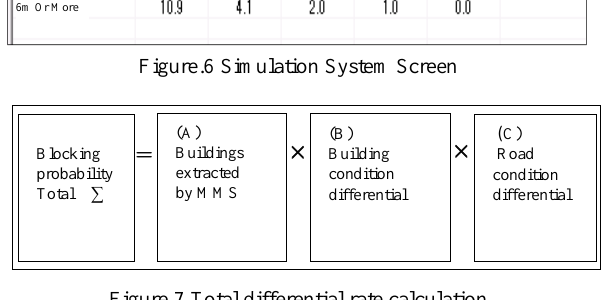
Figure.7 Total differential rate calculation